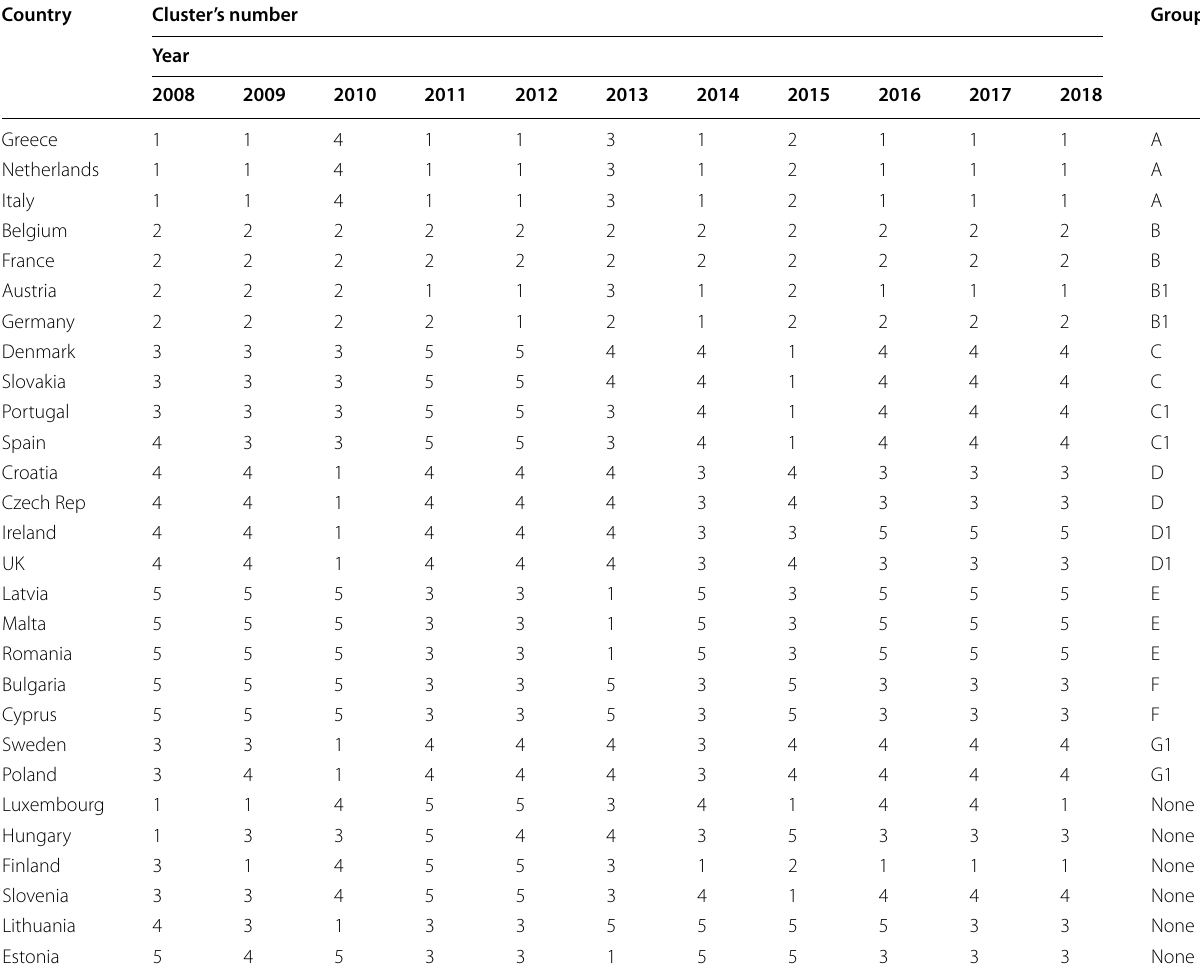
Source Own calculations based on the data from Eurostat